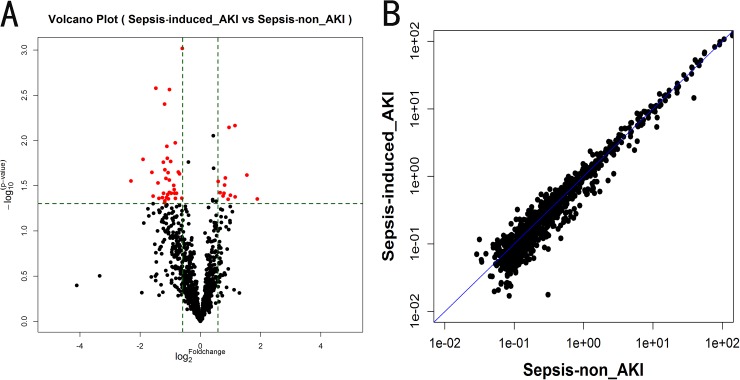
Volcano plot (A) and scatter plot (B) of the miRNA microarray analysis. (A) Volcano plots are useful tool for visualizing differential expression patterns between two different conditions. The vertical lines correspond to 1.5-fold up and down, respectively, and the horizontal line represents a P value of 0.05. So the red point in the plot represents the differentially expressed miRNAs with statistical significance. (B) The scatter plot is a useful visualization for assessing the variation (or reproducibility) between chips. The axes of the scatter plot are the normalized signal values of the samples (the ratio scale).